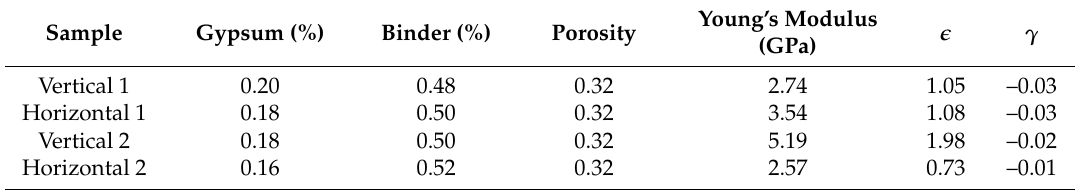
Table 2. Upscaling results of four samples using the Mori-Tanaka (M-T)